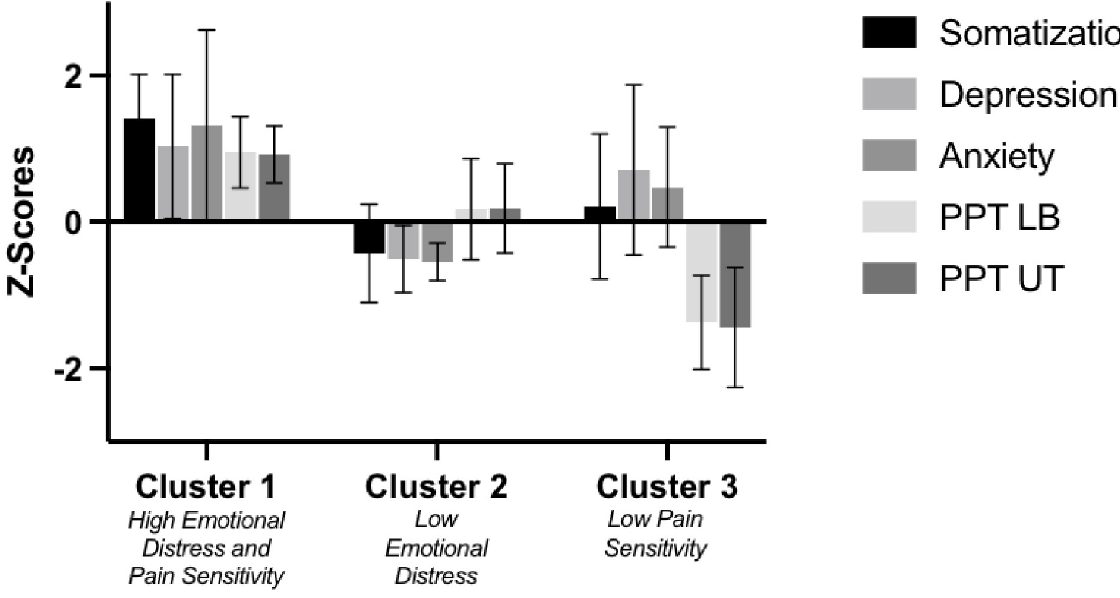
Fig 2. Z-scores of variables by phenotype.